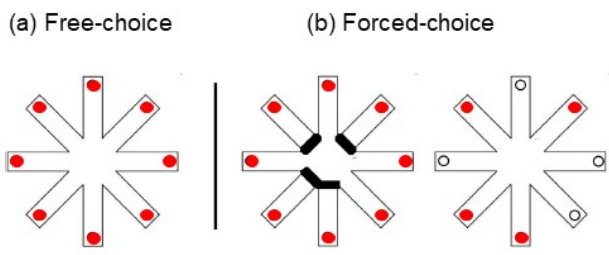
Figure 2. Free-choice ( a ) and forced-choice ( b ) paradigms are represented .